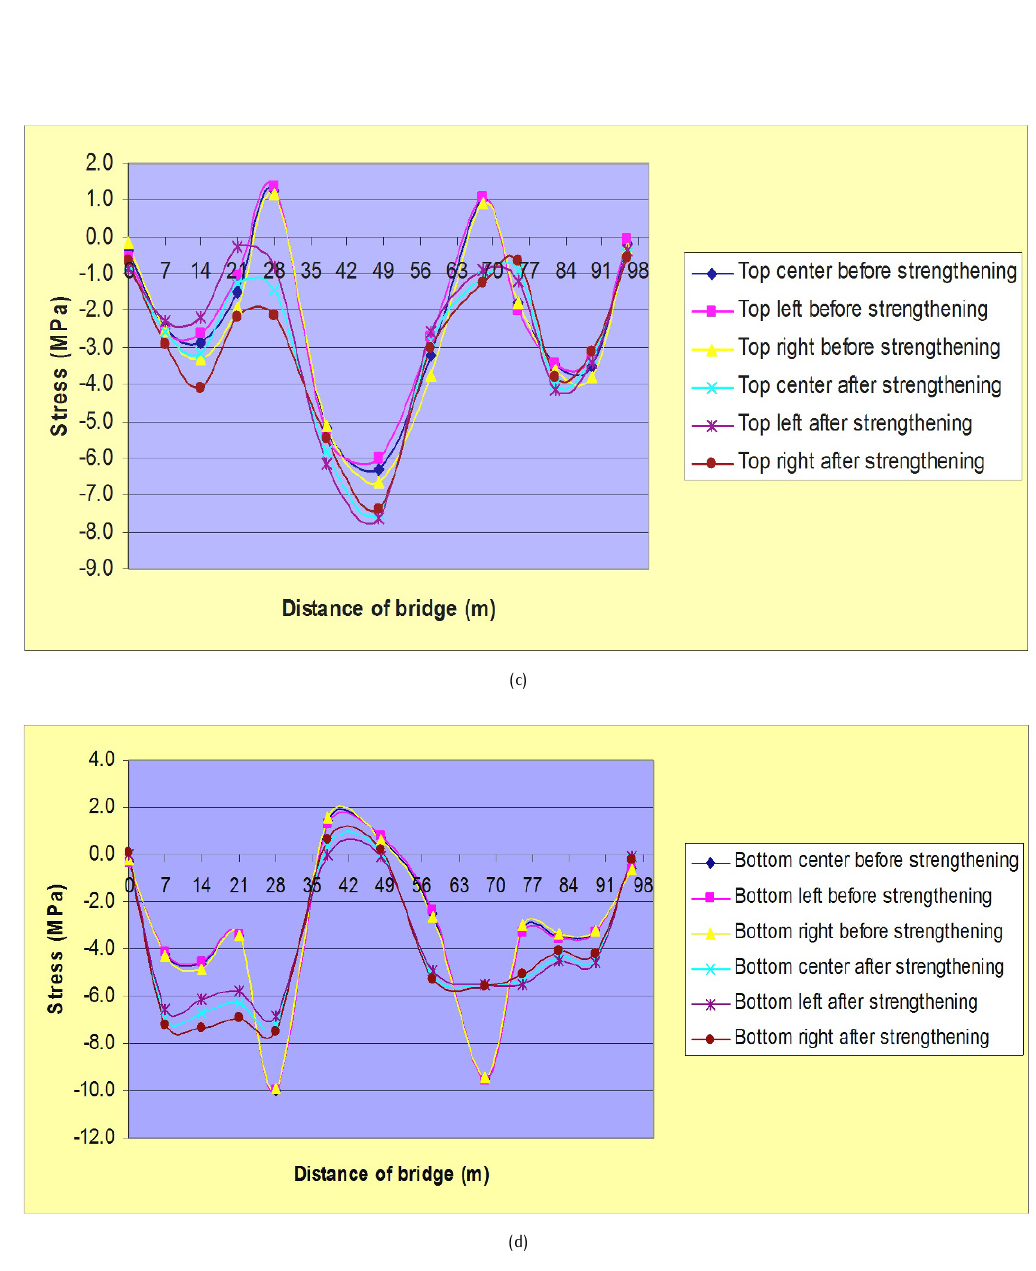
Figure 13. (continued) The values of stresses before and after strengthening due to load combination II for object No.1, (c) Min. top value of box girder, (d) Min. bottom value of box